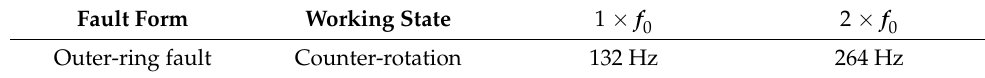
Table 3. The FCF of the OR fault.